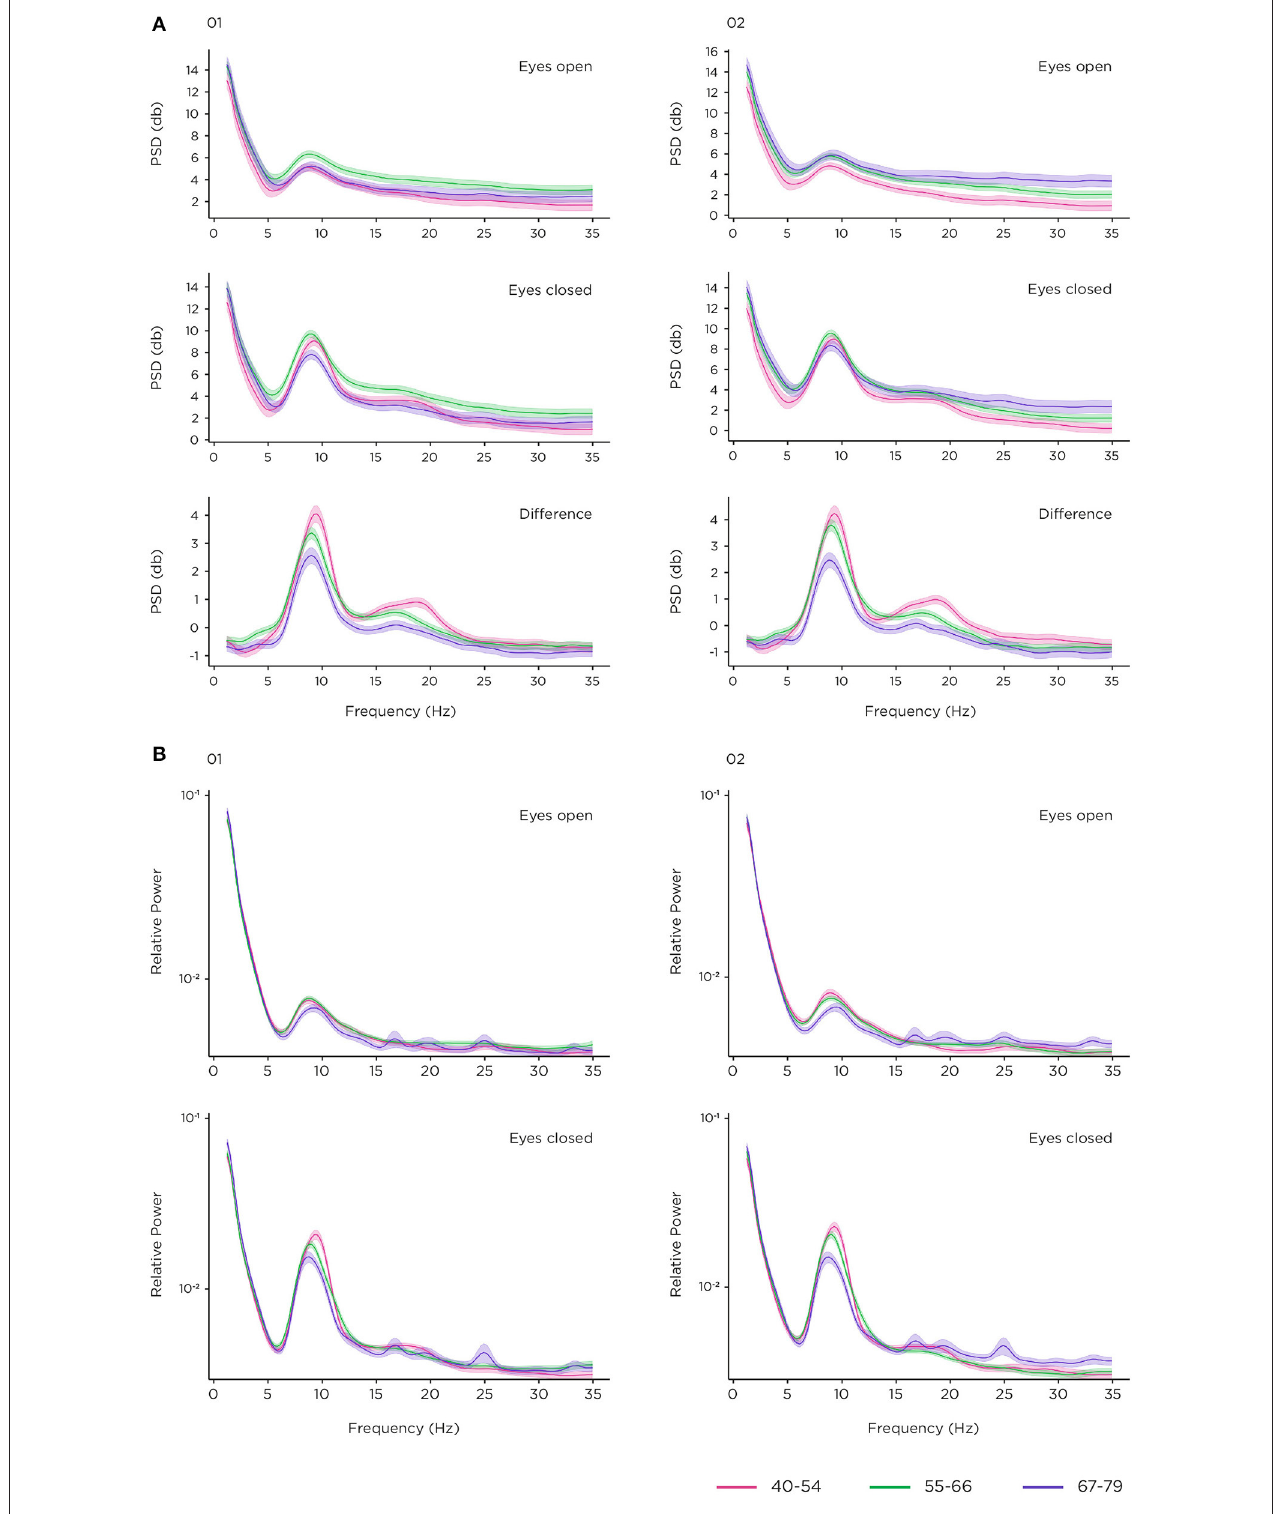
FIGURE 7 | Resting state task. (A) power spectral density (PSD) in decibels (dB) at O1 and O2 by age group in eyes-open and eyes-closed conditions, and the difference condition; (B) relative power at O1 and O2 by age group in eyes-open and eyes-closed conditions with logarithmic scaling for display only.